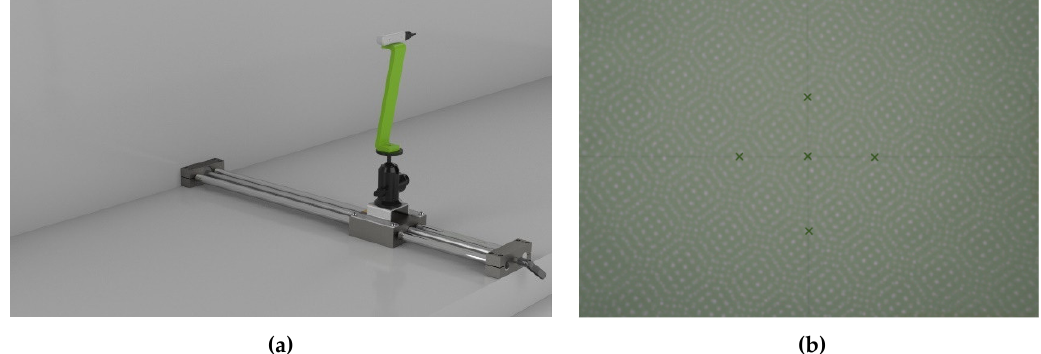
Figure 12. ( a ) The acquisition setup for systematic depth error evaluation test: the camera is mounted on a linear guide perpendicular to a planar surface. ( b ) Example of left camera frame acquisition of the reference plane with the physical